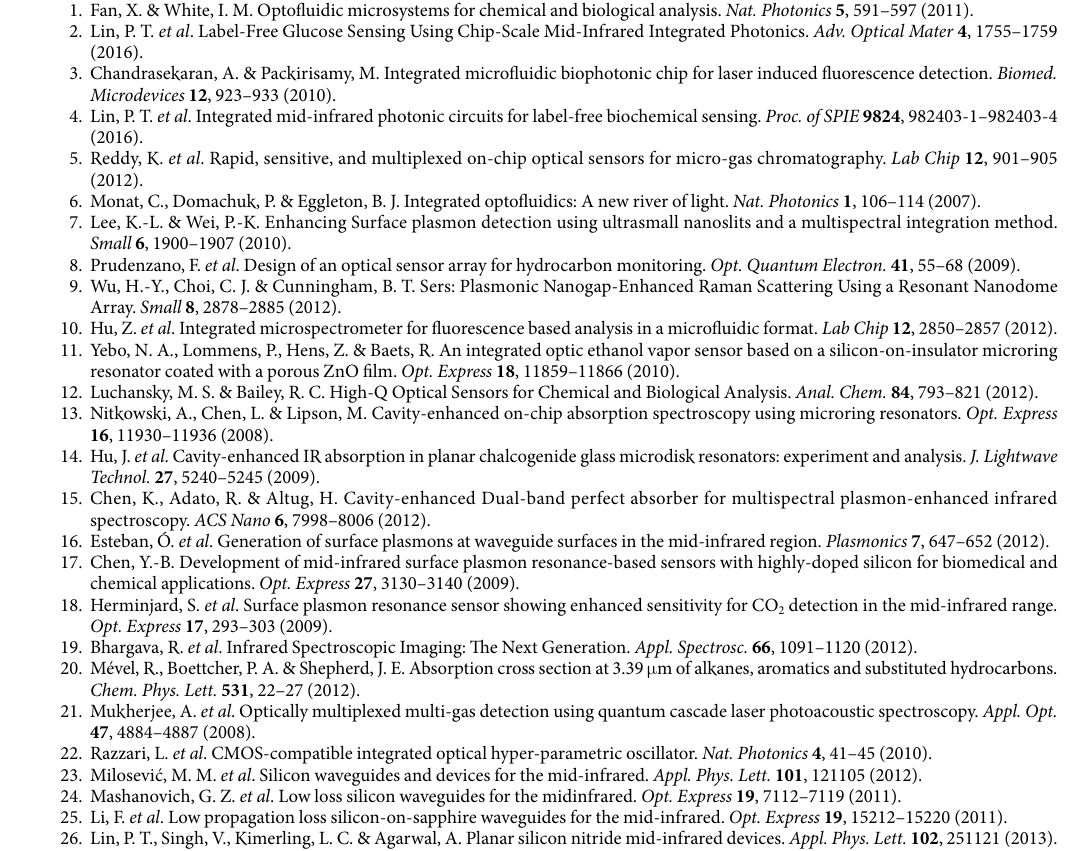
monitored by an upper microscope equipped with a long working distance 10x objective lens. The mid-IR light emitted from the waveguide end facet was focused by a barium fluoride biconvex lens with a 25 mm focal length and then imaged by a 640 × 512 pixel InSb camera cooled by liquid nitrogen. In the chemical sensing tests, 1 mL solution was dropped from a syringe onto the Mid-IR waveguide sensor with 1 cm 2 surface area to ensure that the solution covers the entire waveguide array. The organic solvents include heptane and methanol ( ≥ 99.9%, Sigma-Aldrich). The chemical mixtures were prepared by weight percentages. During sensing experiments the temperature was maintained at 25 °C.